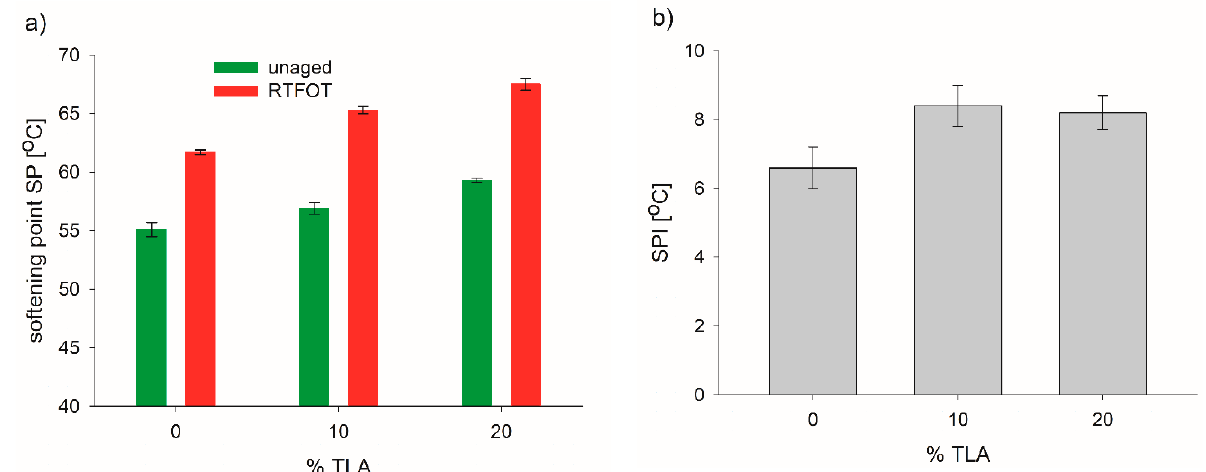
Figure 2. Softening point ( a ) and softening point increase ( b ) before and after the RTFOT aging of modified binders for different TLA contents.